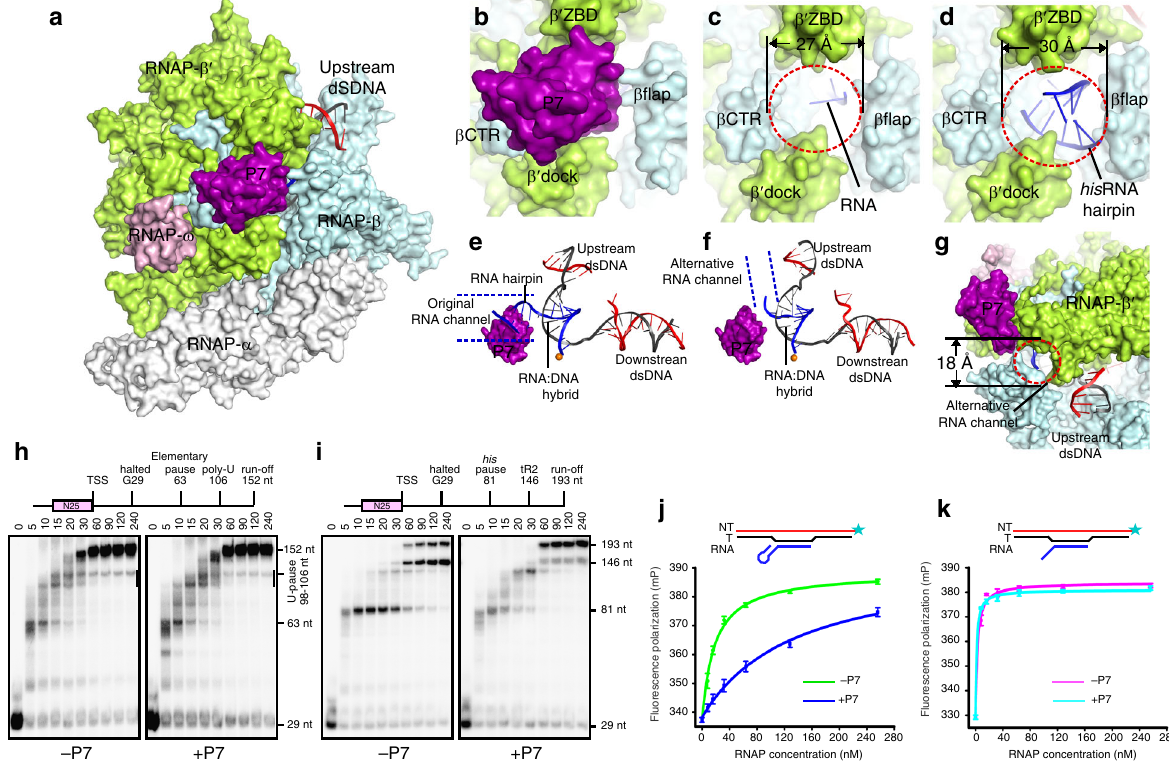
Fig. 3 P7 inhibits pausing and intrinsic termination by preventing formation of RNA hairpin in the RNA-exit channel. a The surface presentation of P7- NusA-TEC shows the binding site of P7 on RNA polymerase. b The close-up view of P7 and its binding site. c The RNA-exit channel and RNA path in E. coli transcription elongation structure (PDB: 6ALF). The RNA-exit channel is in surface presentation and the RNA (blue) is shown as cartoon. d The RNA-exit channel and RNA hairpin (blue) in the E. coli paused elongation complex ( Ec PEC; PDB: 6ASX). The RNA-exit channel is in surface presentation and the RNA hairpin (blue) is shown as cartoon. e Structure superimposition of Xoo P7-NusA-TEC and Ec PEC shows a steric clash between P7 and RNA hairpin in the RNA exit channel. f P7 guides the RNA to exit through an alternative gate. g The surface presentation showing the alternative RNA-exit gate in the P7- NusA-TEC structure. h P7 shows marginal effect on transcription pauses at elemental and poly-U pause sequences. i P7 substantially inhibits hairpin- dependent pause and intrinsic termination. j P7 signi fi cantly inhibits RNAP from binding a nucleic-acid scaffold with an RNA hairpin. k P7 has no effect on binding af fi nity of RNAP to an elongation nucleic-acid scaffold without RNA hairpin. The experiments were repeated in triplicate, and the data